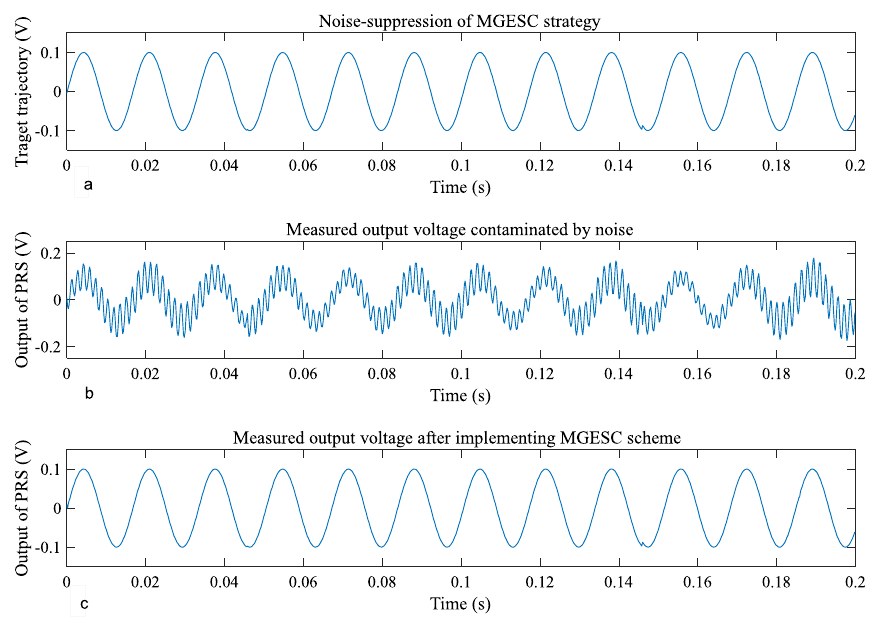
Figure 9. Noise suppression of the MGESC scheme in time-domain.